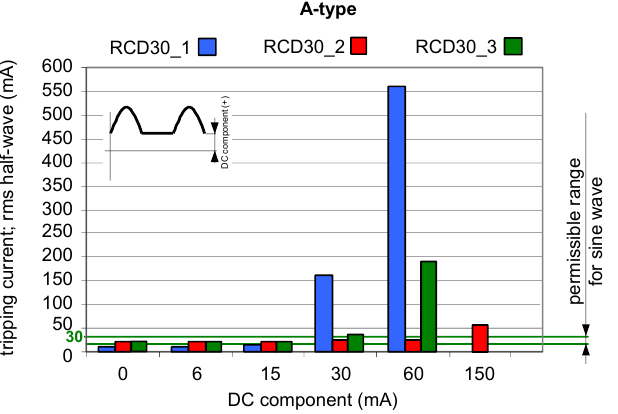
Figure 9. Tripping current (rms value of the DC pulsating component) of three 30 mA A-type RCDs under pulsating DC (half-wave) current superimposed by smooth DC component of values 6, 15, 30, 60, and 150 mA. Both components have positive (+) polarity.